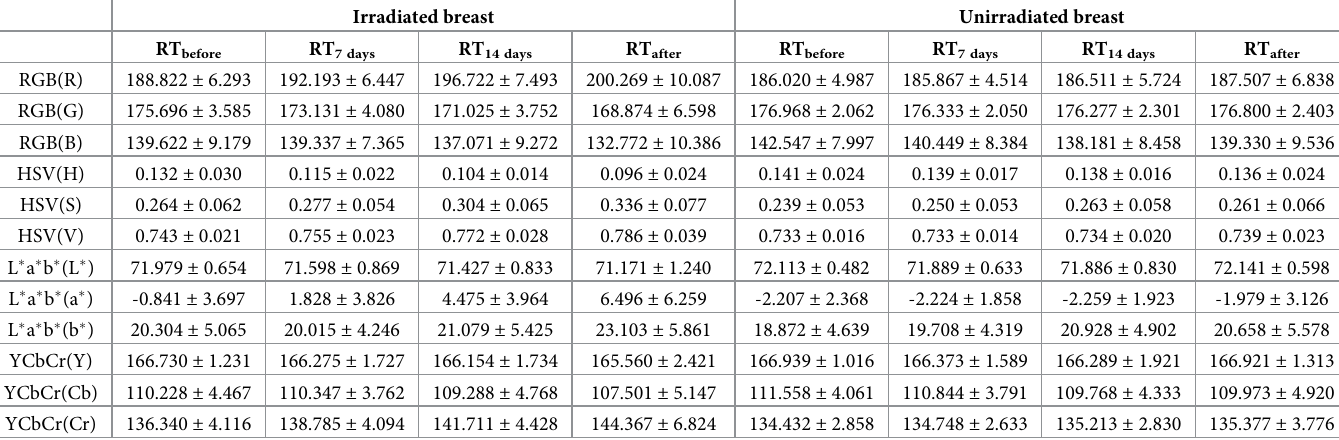
Table 3. Mean and standard deviation values of color space parameters for irradiated and unirradiated breasts. Irradiated breast Unirradiated